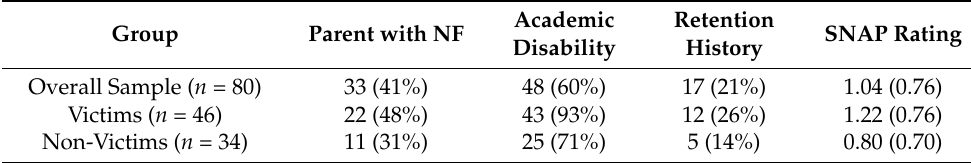
Table 3. Risk factor frequencies by child-reported group.